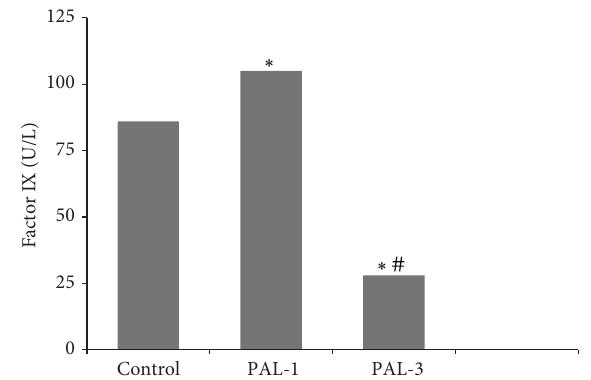
Figure 2: Factor IX levels in control, PAL-1, and PAL-3 groups. PAL-1 group: receiving paliperidone 1mg/kg for ten days; PAL-3 group:receivingpaliperidone3 mg/kgfortendays. ∗ 𝑃 < 0.05 versus control group. # 𝑃 < 0.05 versus PAL-1